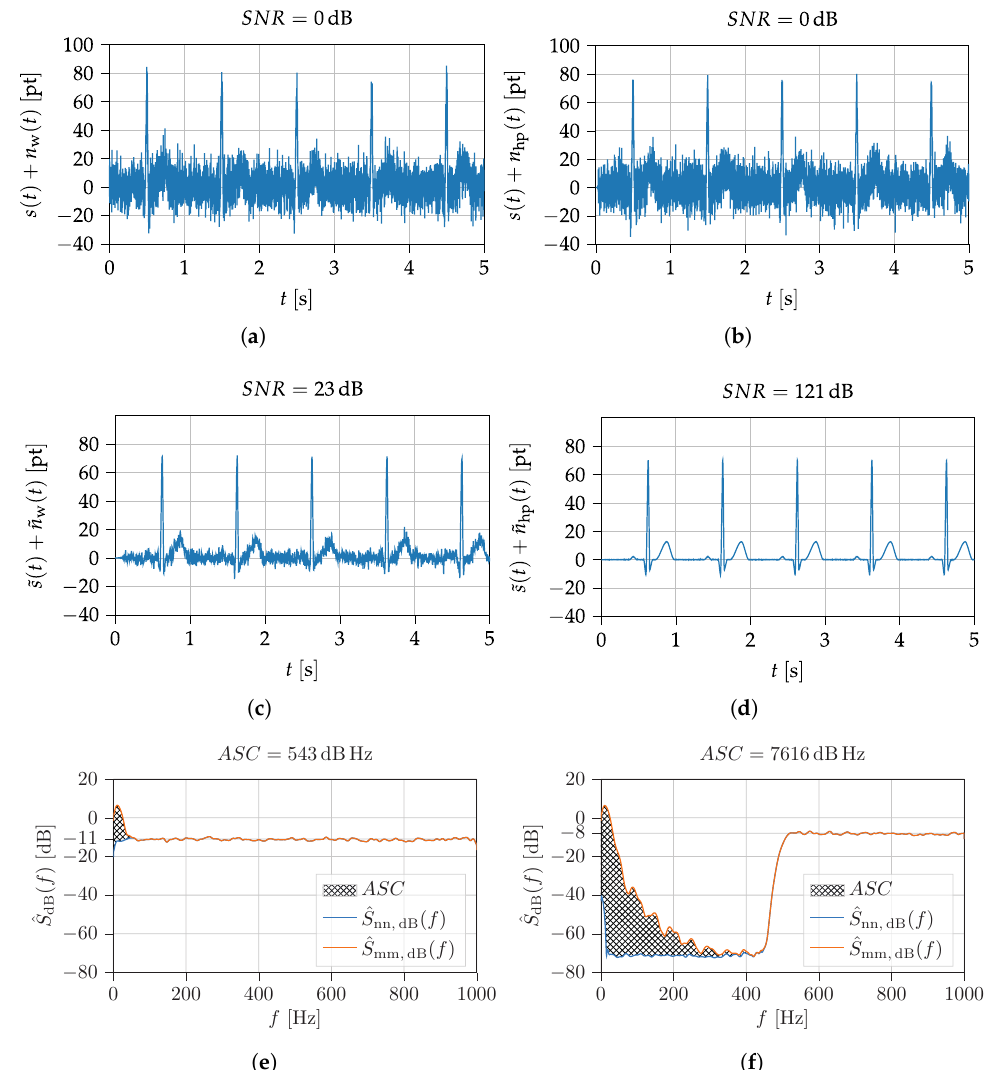
Figure 9. MCG-Prototype signals (cf. Figure 7b) superimposed with white noise (left column) and high-pass filtered noise (right column). The second row shows the low-pass filtered sum of the signal and noise, while the third row shows application specific capacity and the power spectral densities of the signal, noise and weighted noise (cf. Equation (39)). ( a ) MCG Signal plus white